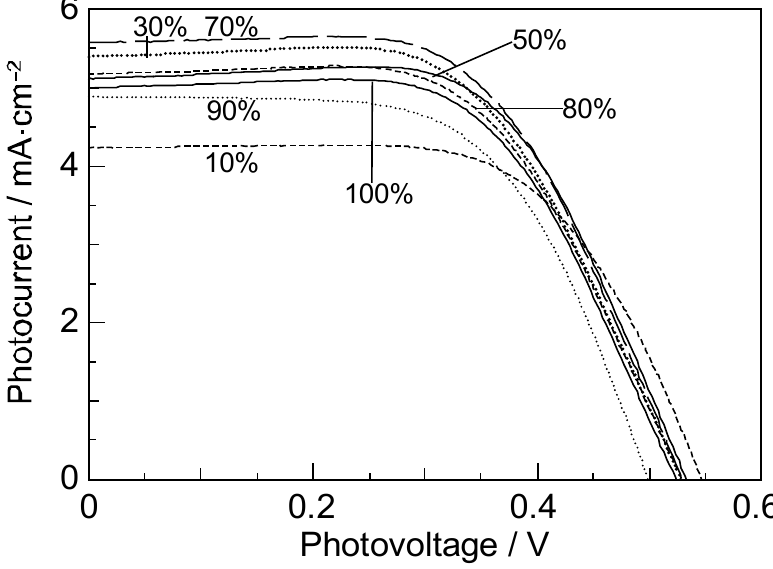
Figure 9. Concentration dependence of the I – V curves in CA7-sensitized solar cell (reprinted from [3] with permission of Elsevier).